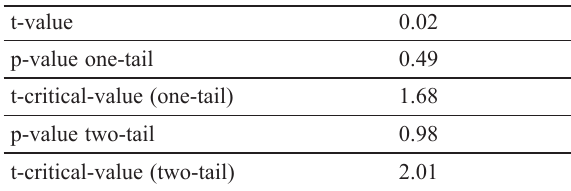
Table 5. The t-test result for comparing results produced by FARB and Monte Carlo simulation t-value 0.02